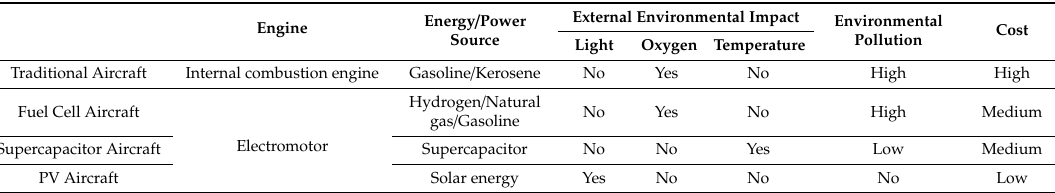
Table 1. Comparison among the conventional aircraft with three types of electric aircraft.